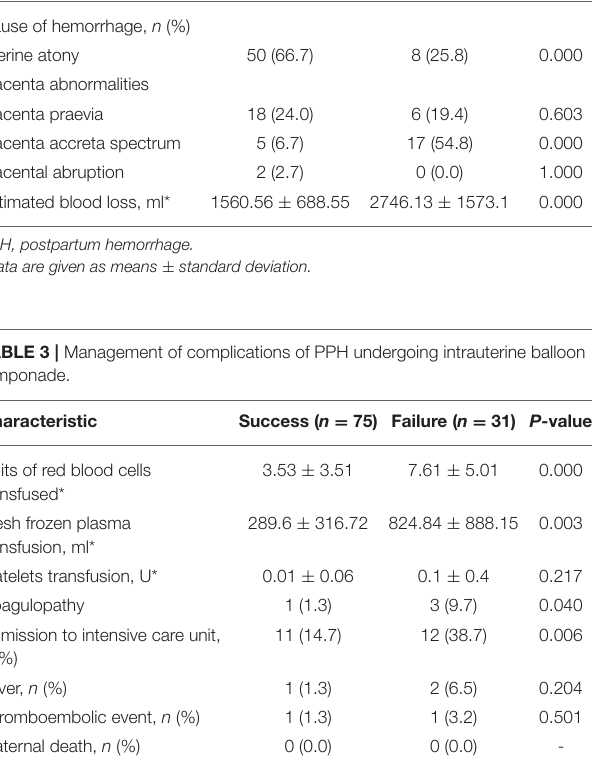
( Table 4 ). The AUC is